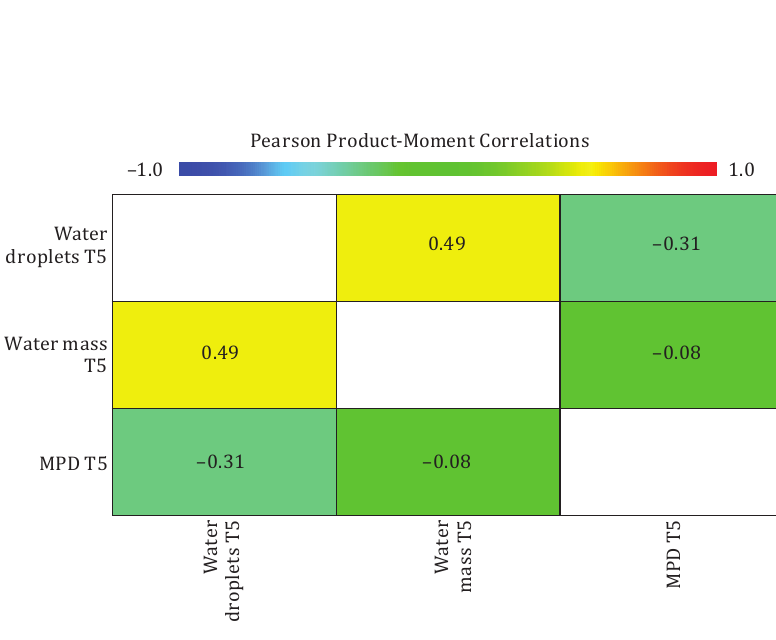
Figure 18. Pearson product-moment correlations between each pair of variables for Test Track